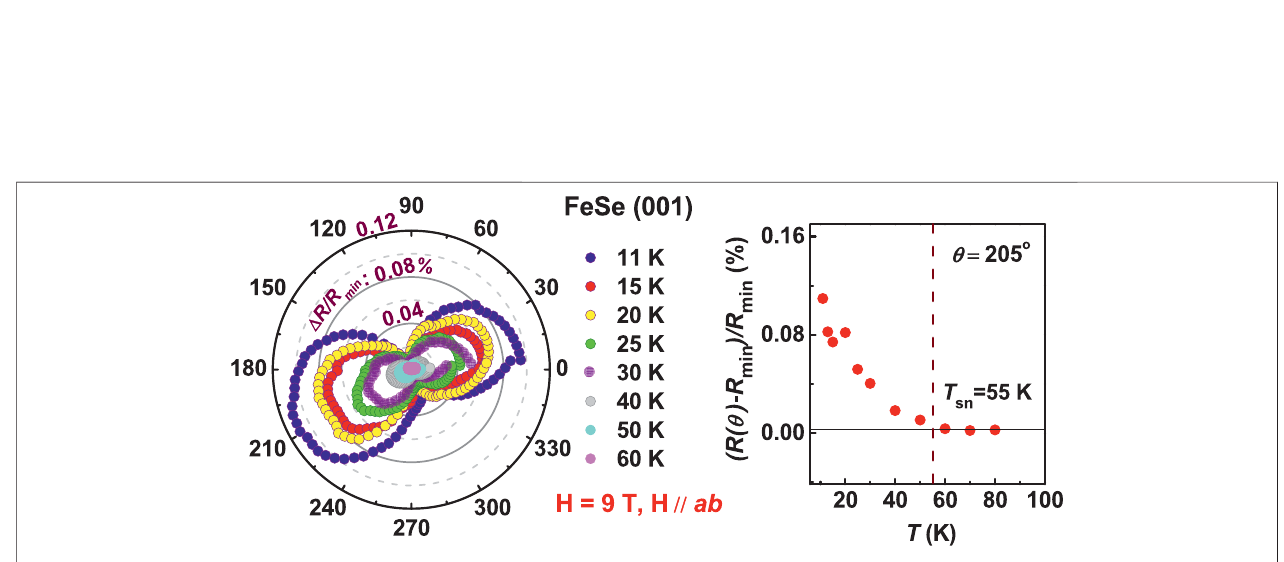
FIGURE 6 | Temperature dependences of the angular-dependent magnetoresistance of FeSe crystal ( T c (cid:1) 7.6 K), showing the twofold rotational symmetry below T sn ∼ 55 K [64].